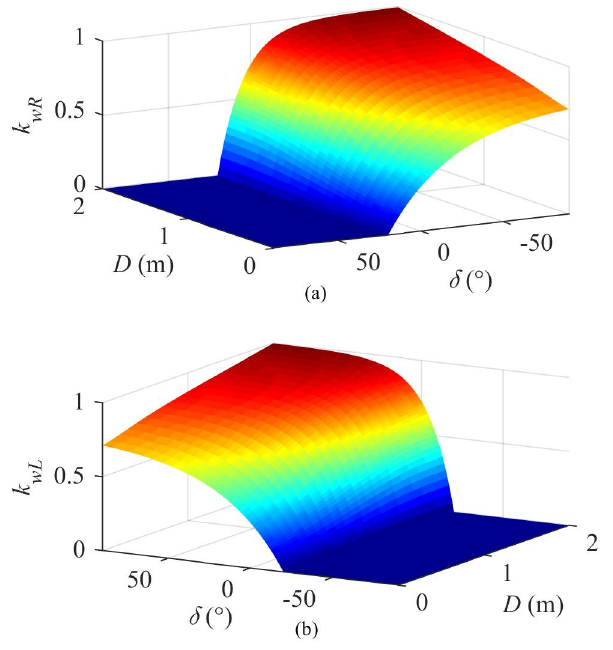
Figure 14. Fuzzy control surfaces of the maximum speed: ( a ) of the right motor; ( b ) of the left motor approximated with exponential function with approximation of steady state K p by a polynomial of the first order and approximation of the starting angle δ n by a polynomial of the sixth order and at the displacement angle δ 0 = − 20°. Comparison of the control time, absolute, and quadratic control area values for each fuzzy control area approximation method is shown in Table 2. Differences between fuzzy control surface approximation methods can also be shown on the paths of the mobile robot simulation from the beginning of the coordinate system to the target point, which is at distance of 10 m in Figure 15. Table 2. Impact of fuzzy control surface approximation methods on the control quality of the mathematical model of the mobile robot EN20.